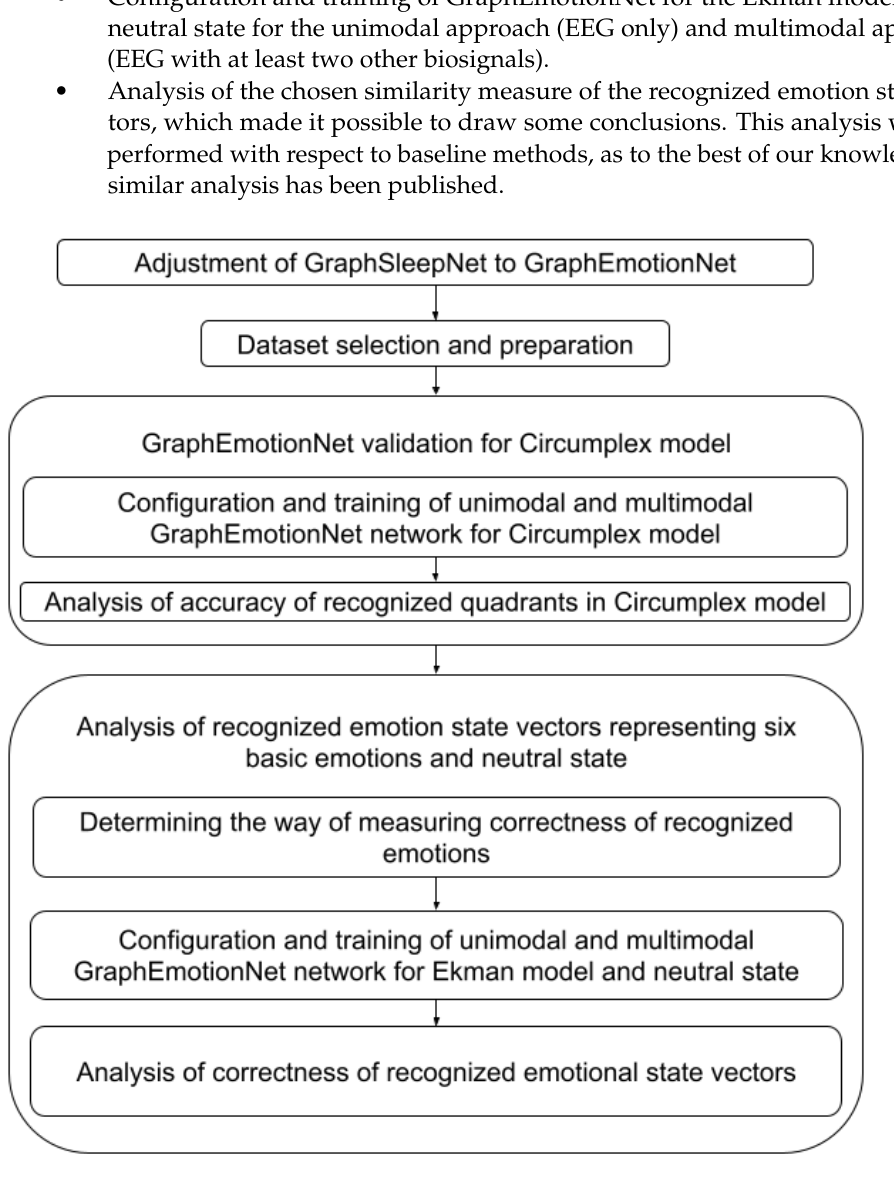
Figure 1. Research